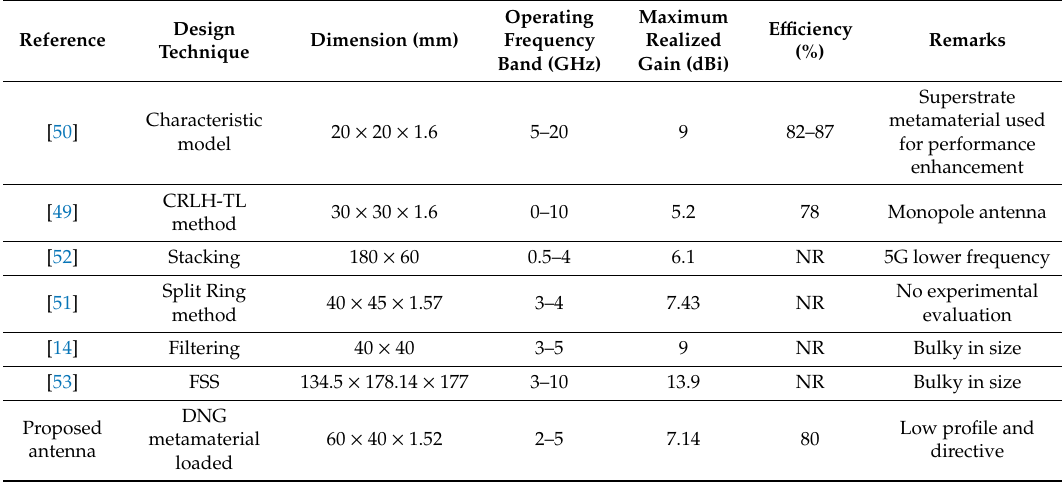
Table 2. Performance comparison of the proposed antenna with relevant reported